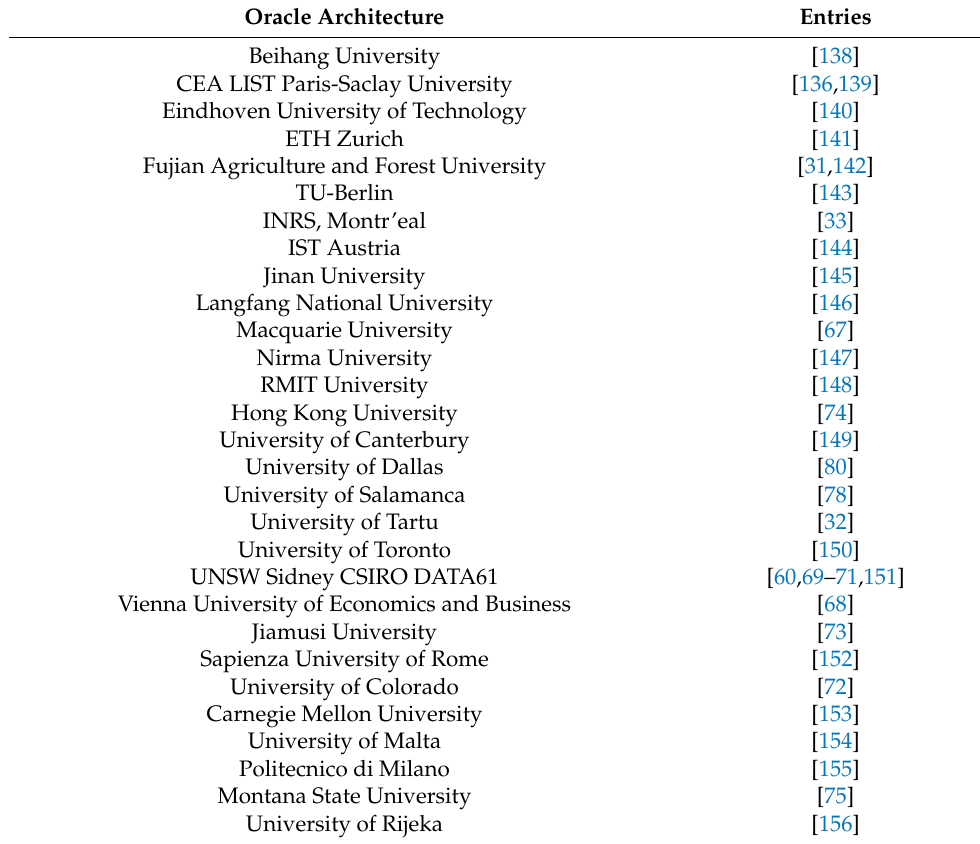
Table A3. Complete list of articles sorted by